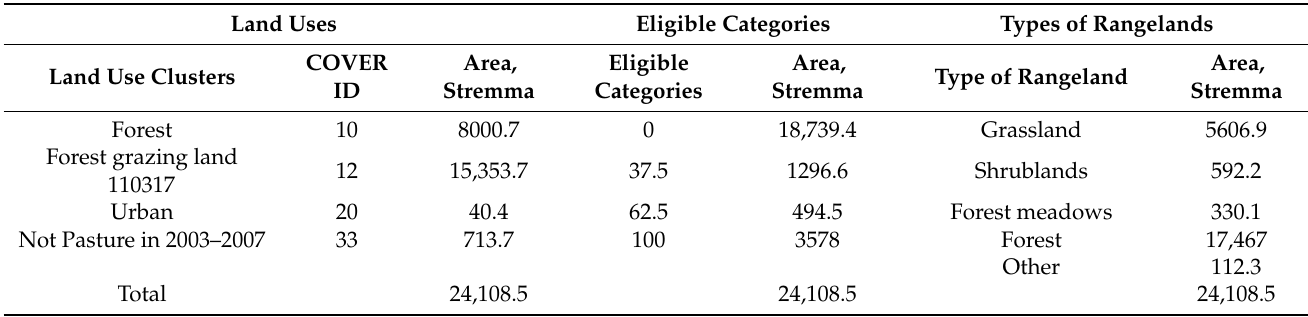
Table 2. Land uses and eligible categories in Pisoderio pasture, according to ILOTS 2014, and also types of rangelands.